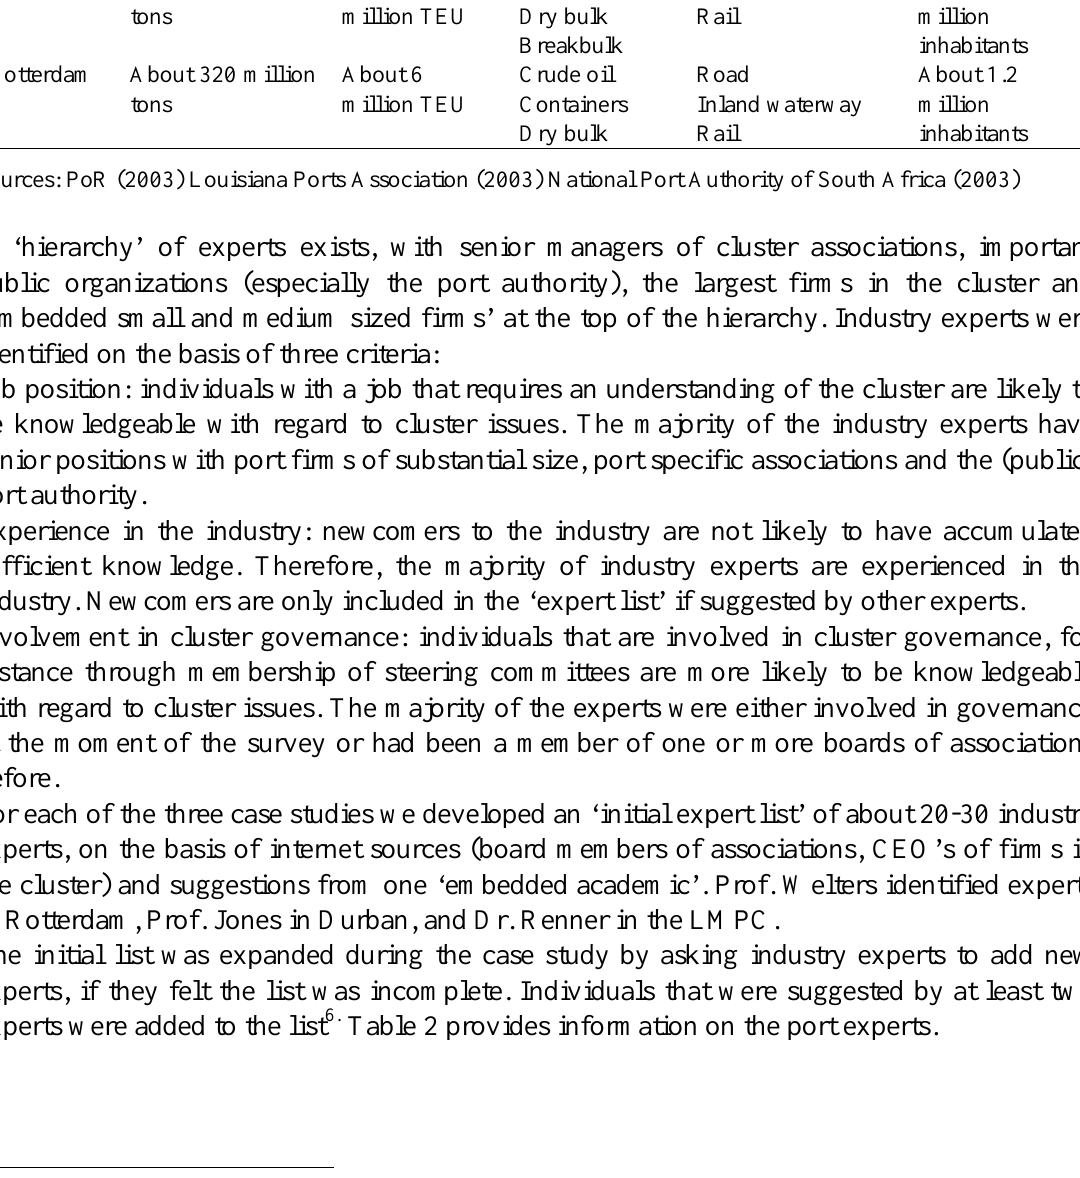
Table 1. Characteristics of the three cases (figures for 2002) Port Total throughput Container LMPC About 381 million About 0.3